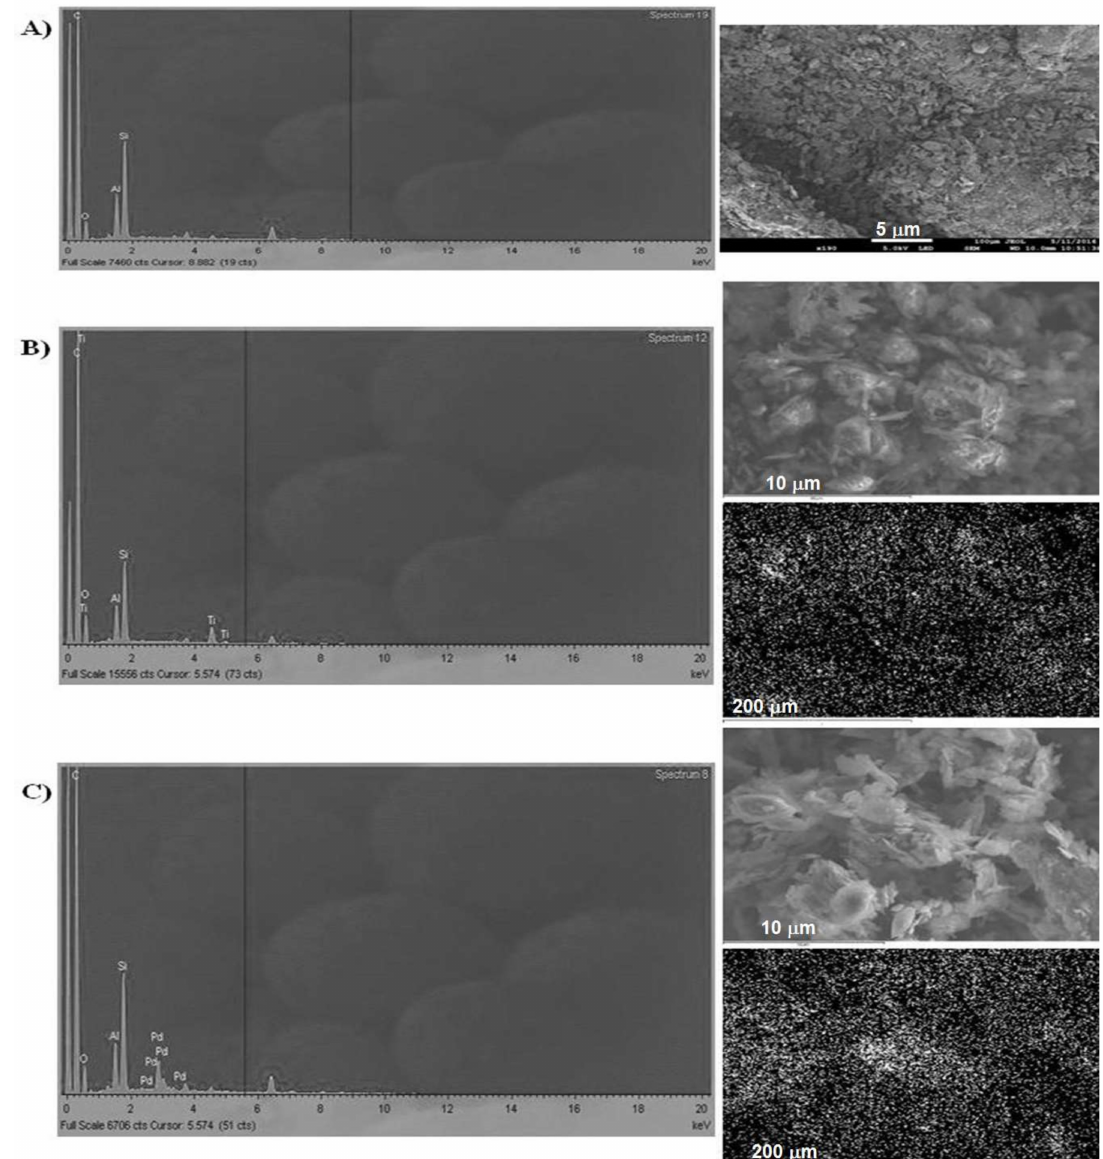
Figure 1. Results for SEM and energy-dispersive X-ray (EDX) characterization of: graphite powder ( A ), and carbon nano-modified powder with titanium ( B ) and palladium ( C ) oxide